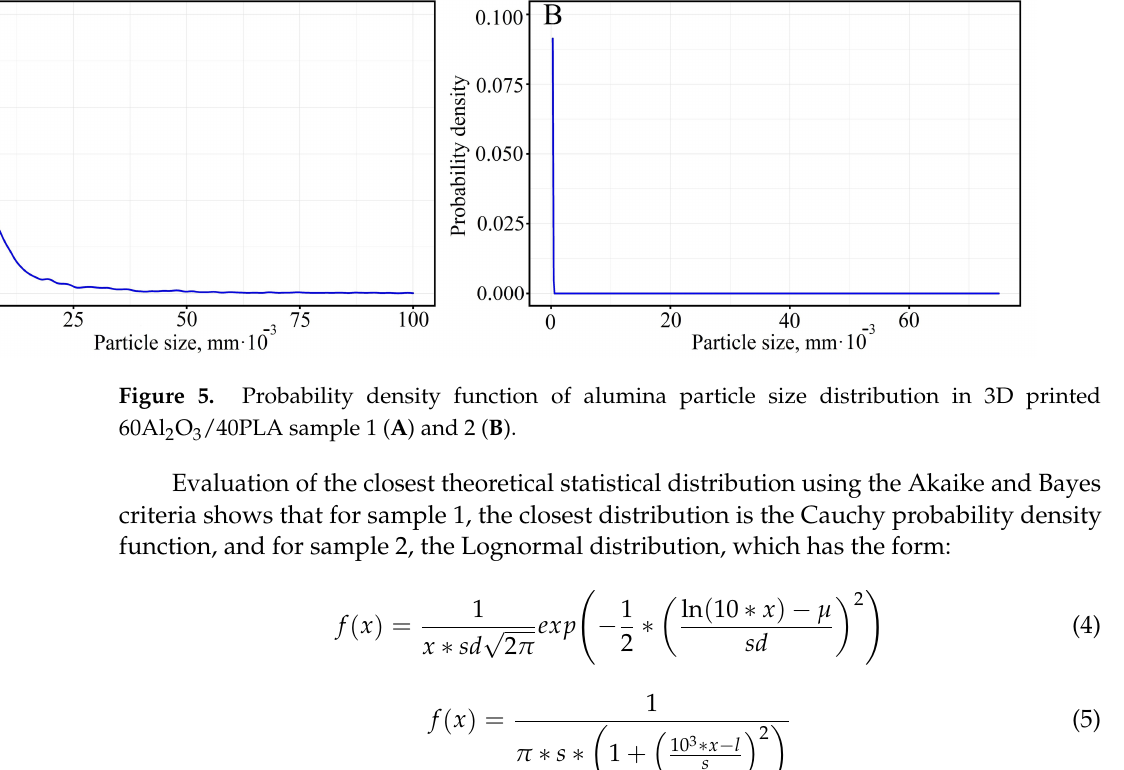
8 of 11 Table 4. Values of the shape parameter and scale factor for printed 60Al 2 O 3 /40PLA samples 1 and 2 distributions. Coefficient Value at an Interval